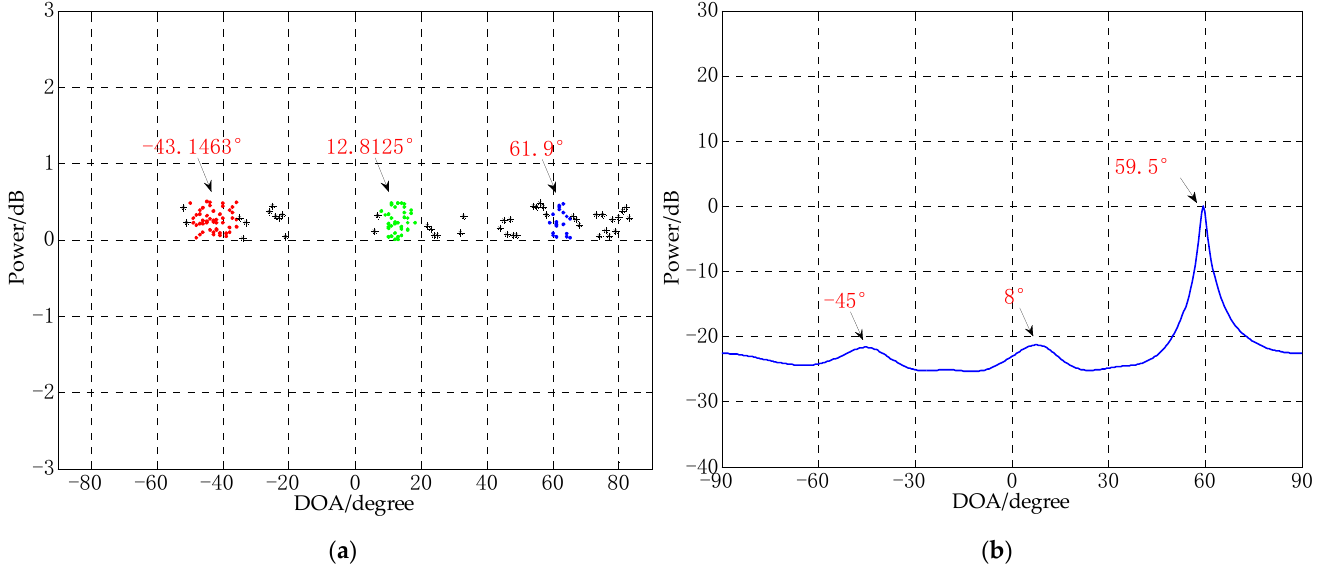
Figure 14. DOA estimation experiment for coherent signal. ( a ) CS-DOA-DBSCAN, ( b ) MUSIC.